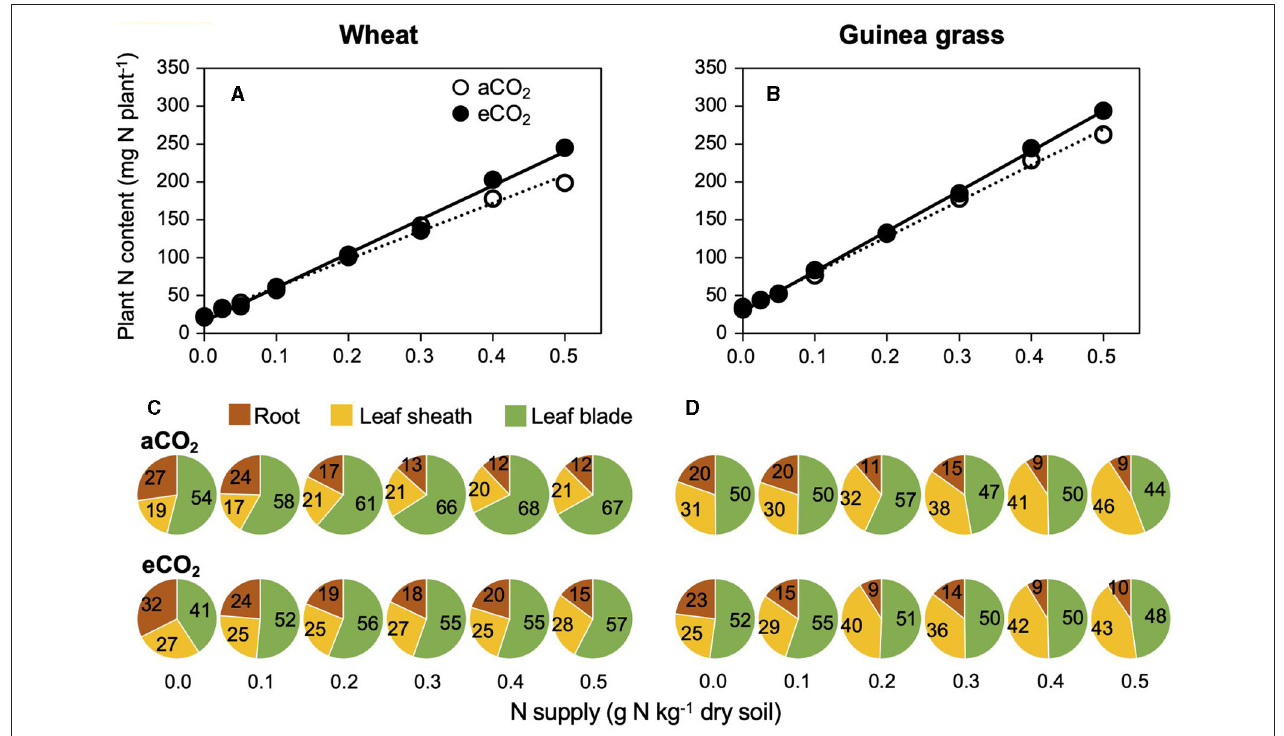
FIGURE 5 | Relationships between plant N accumulation and nitrate-N supply (A,B) , N distribution to each organ (C,D) in C 3 wheat and C 4 guinea grass grown for 28 d in the chambers under ambient (aCO 2 ) or elevated (eCO 2 ) CO 2 treatments. Each value in the pie chart (C,D) shows the percentage within the individual